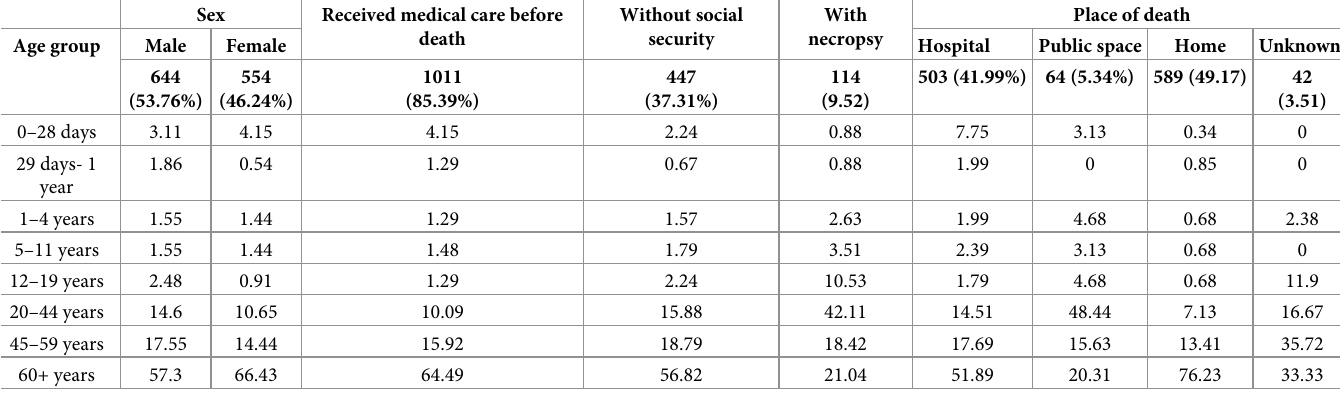
Table 1. General characteristics of deaths in the sample, including information from death certificates Hidalgo, Mexico,